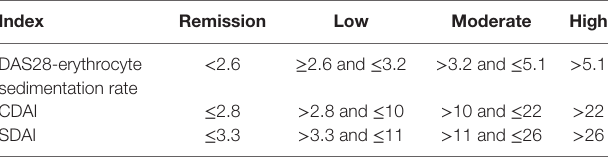
TaBle 1 | Cutoff values for different disease activity states.